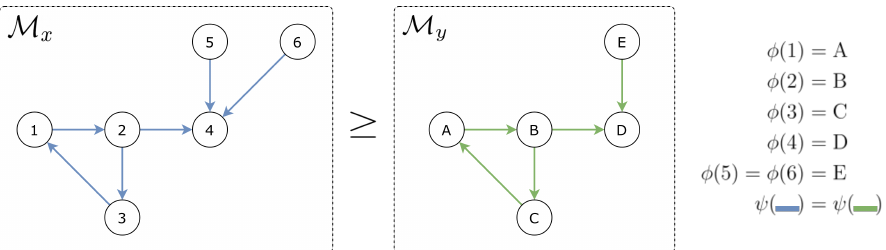
Figure 1. An example of two MDPs for x and y domains where M x ≥ M y . φ : S x → S y and ψ : A x → A y are state and actions maps, respectively. States correspond to nodes and actions to colors. States 5, 6 in S x are merged to state e in S y and blue actions in A x are mapped to green actions in A y .